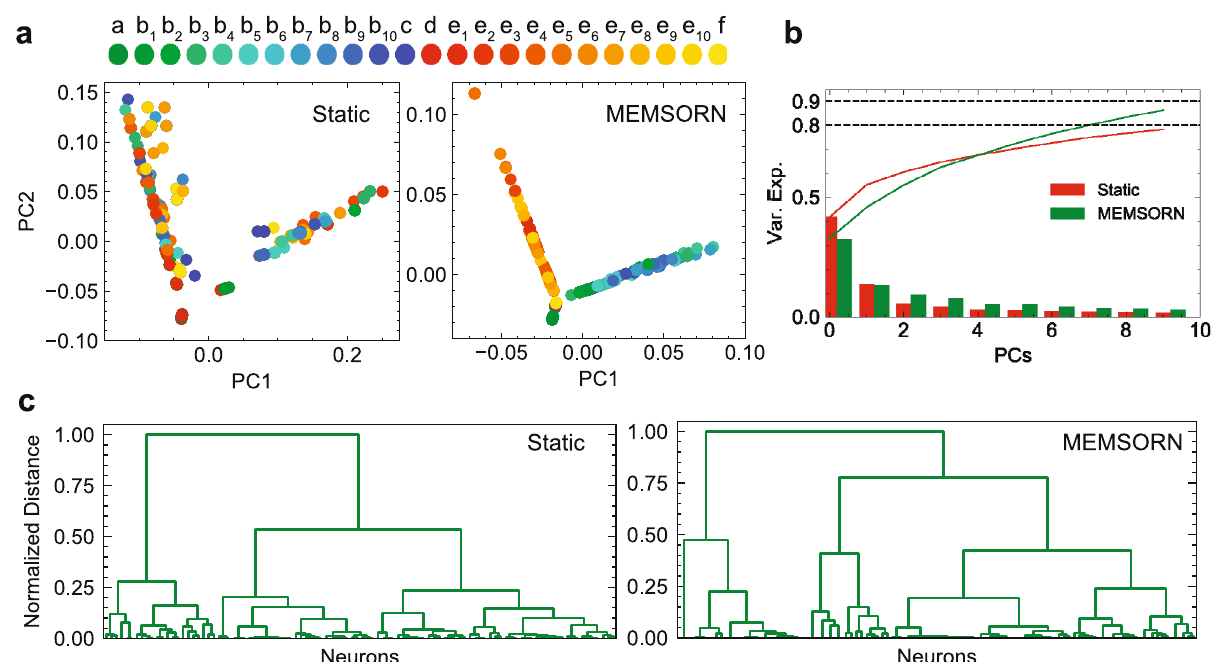
Fig.6|Clusteringanalysisonthespikingactivityofthenetworksforstaticand MEMSORN architectures on the counting task with a sequence length of 10. a Principal Component Analysis (PCA) was applied to the fi ring rate of the two networks in response to 50 sequences of length 10 (600 letters). Each color is assigned to a different position of the letter in the sequence with similar colors encoding the temporal adjacency of the letters in the sequence. In the Principal Component (PC)space, the different input conditions formrandom clustersinthe static network that are not well separated. On the other hand, in MEMSORN net- work compact clusters are formed which are well separated for different input